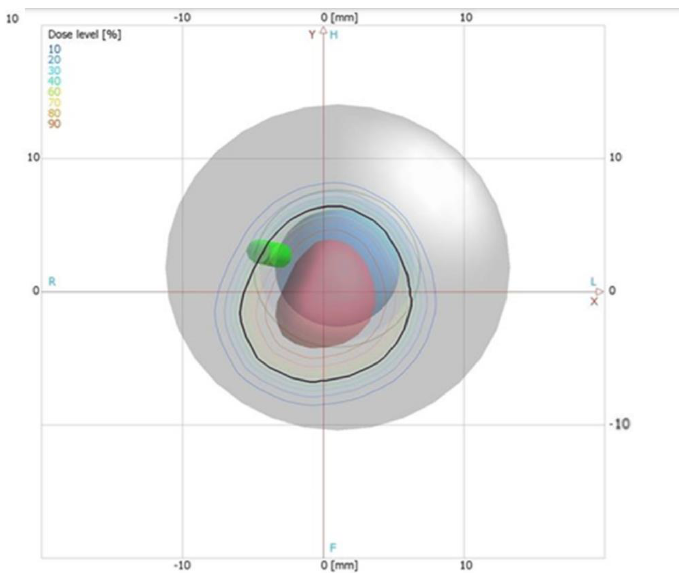
Figure 2. Beam’s eye view, eye front orientation from the Eclipse Ocular Proton Planning system. The black line is the shape of the collimator aperture (see also Figure 4) surrounding the tumor shape (red area). The isodoses represent the dose distribution in the eye on an X-Y section through